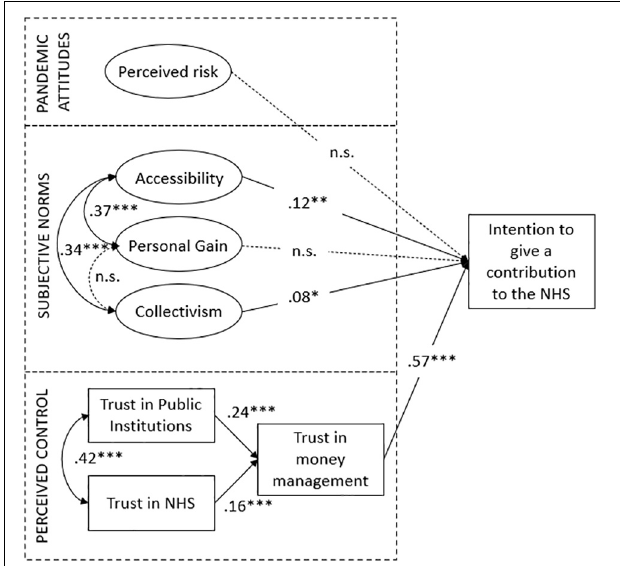
FIGURE 2 | Final model of relationships between antecedents and intention to make a financial contribution to the NHS ( N = 600). Standardized parameter estimates for the final model. *** p < 0.001; ** p < 0.01; * p < 0.05.